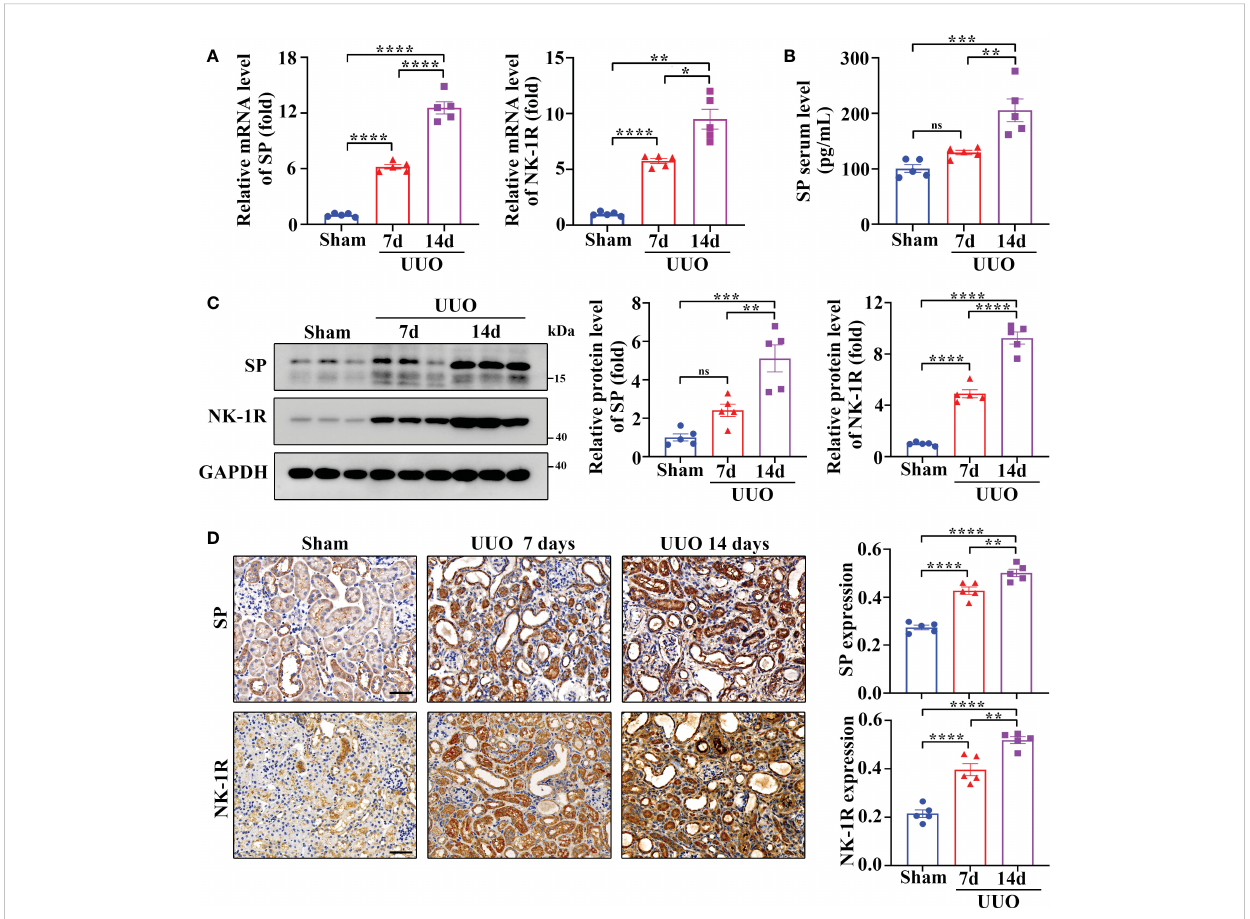
FIGURE 2 Renal SP/NK-1R and serum SP were overexpressed in a mouse unilateral ureteral obstruction (UUO) model. (A) RT-qPCR exhibited increased levels of SP and NK-1R mRNA in cortical lysates of kidneys on days 7 and 14 after UUO. (B) ELISA analysis displayed elevated serum SP levels on days 7 and 14 after UUO. (C, D) Western blot analysis and immunochemistry staining showed that the protein levels of renal SP and NK-1R in cortical tissues were up-regulated on days 7 and 14 after UUO. Representative images (left panels) and quantitative data (right panels) are shown. Scale bar, 50 µm. Data are shown as mean ± SEM from groups of fi ve mice. * p < 0.05; ** p < 0.01; *** p < 0.001; **** p < 0.0001; ns, not signi fi